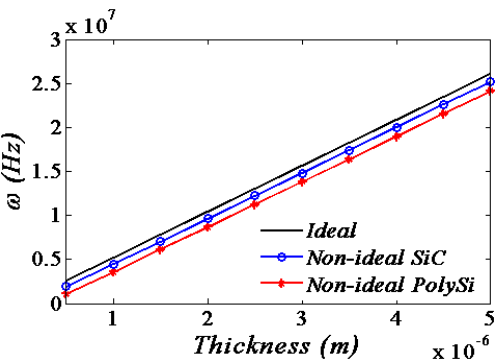
Figure 7. The resonant frequency shift to the beam thickness with respect to the different flexible supports